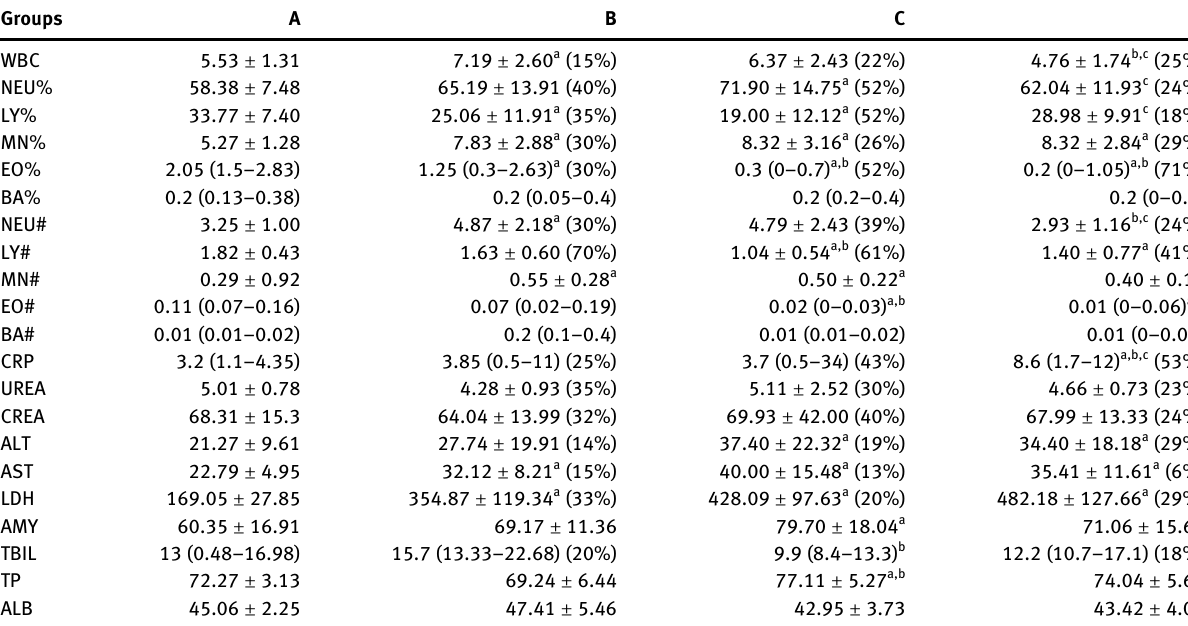
Table  : Comparison of blood indices upon admission between HS, MP-positive patients, Flu A/B-positive patients and SARS-CoV-  -positive patients.